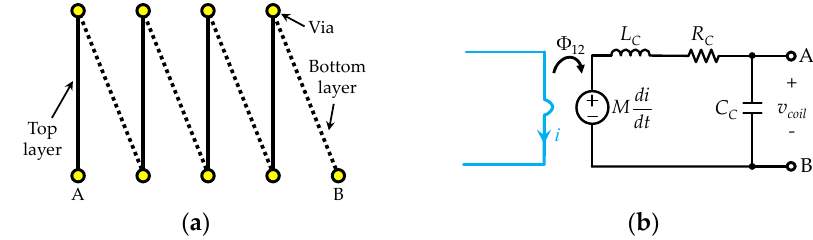
Figure 2. PCB-embedded pick-up coil: ( a ) coil configuration; ( b ) equivalent circuit.